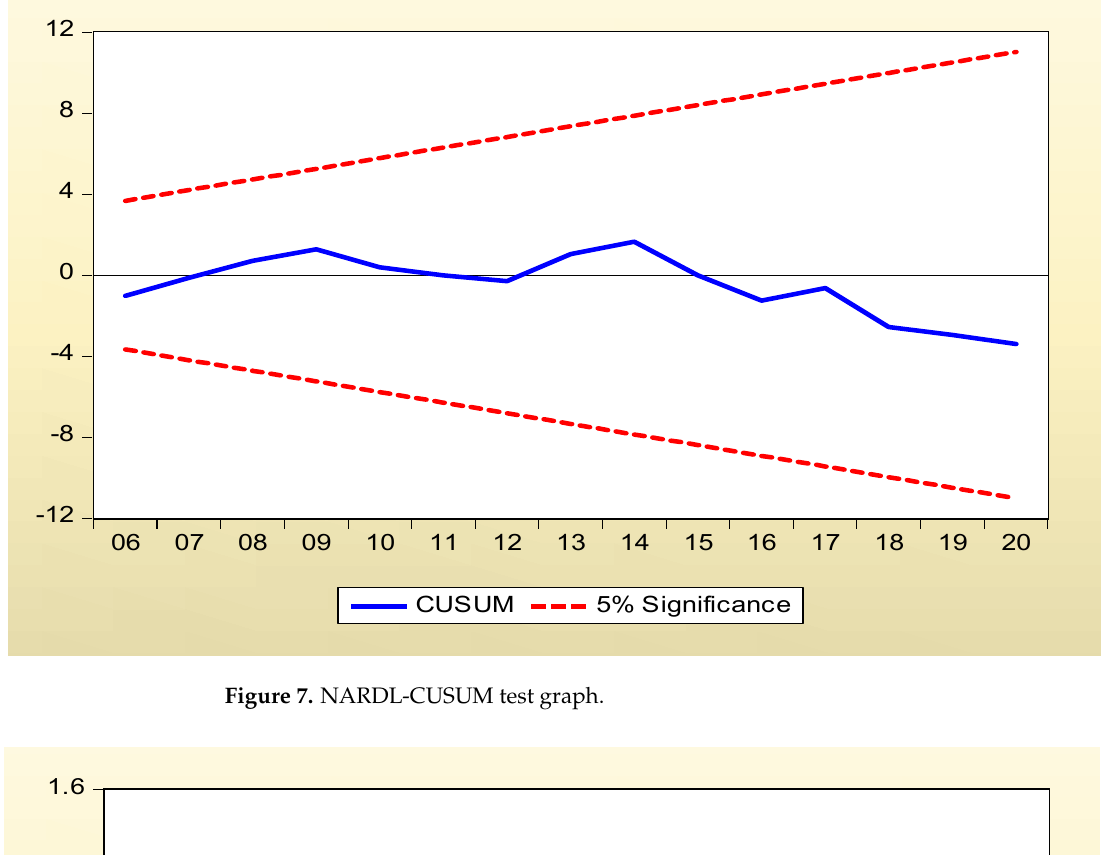
Figure 7. NARDL-CUSUM test graph.